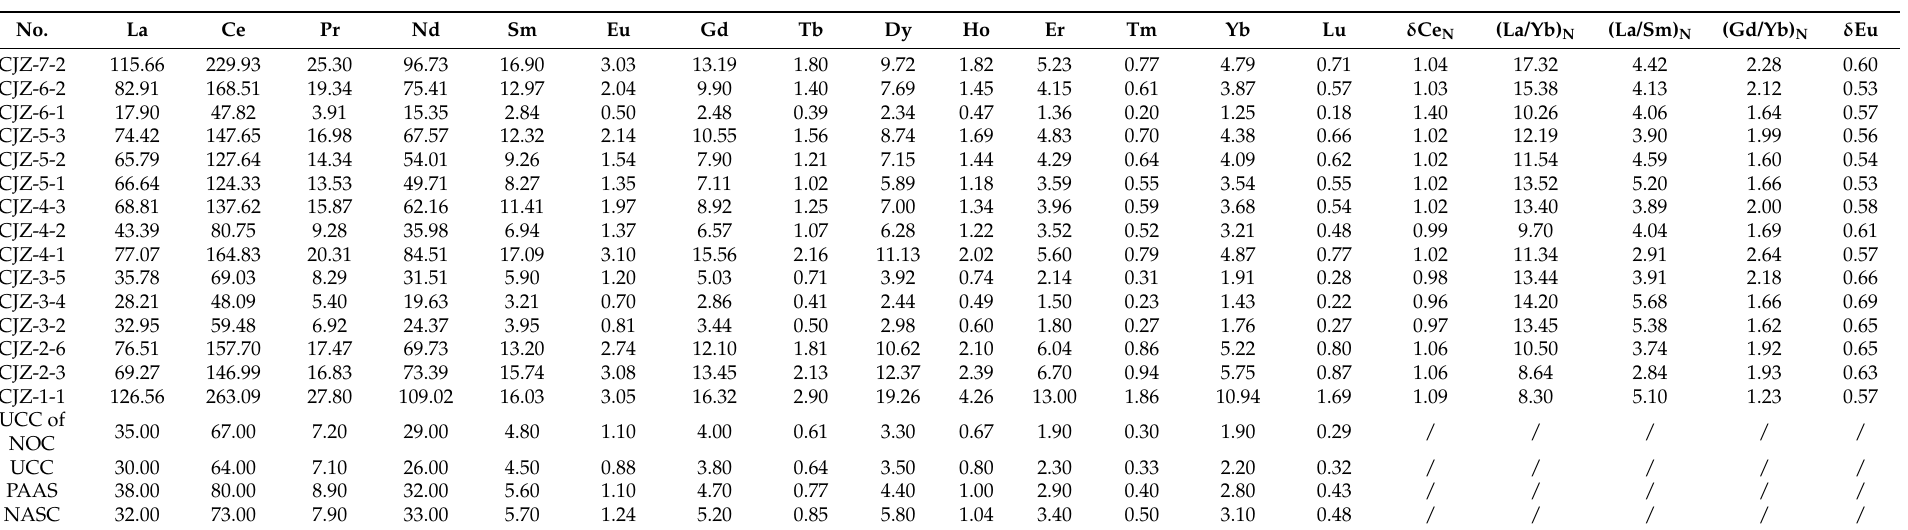
Table 3. Rare earth element compositions of Benxi − Shanxi Formations in the Liulin